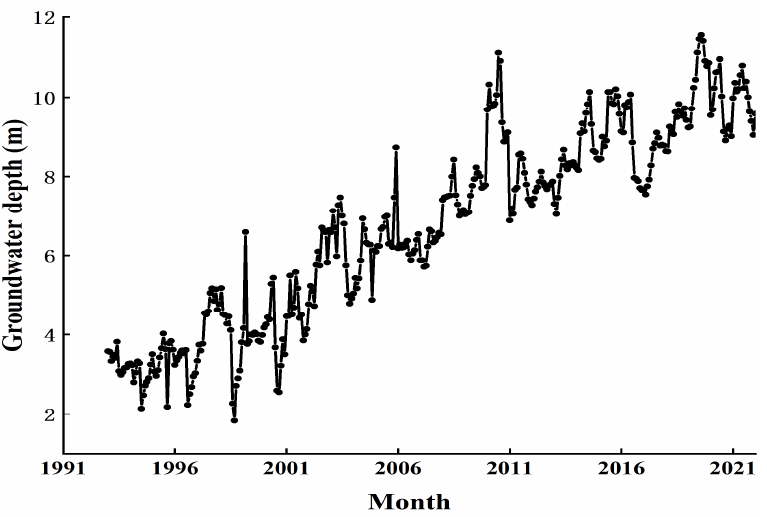
Figure 5. 1993/1–2022/2 Groundwater depth .